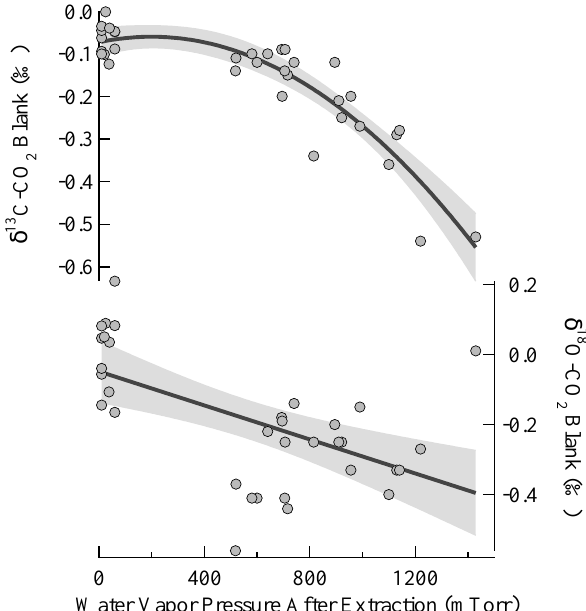
Figure 5. Procedural blank experiments: measurements of the pro- cedural blank of the system and its relationship to water vapor pres- sure. Blank is reported as the difference of the expected δ value (from the NOAA calibration) to the measured value when ice grat- ing and air extraction is simulated. Negative blanks indicate that the standard air becomes more negative during the simulation. The grey shading indicates third-order polynomial fit to the δ 13 C-CO 2 with 95% confidence intervals and linear fit to the δ 18 O-CO 2